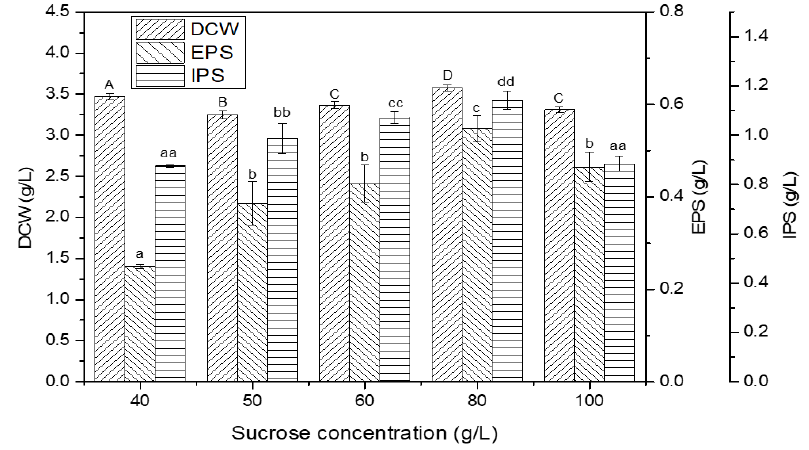
Figure 2. Effect of different sucrose concentrations on mycelial growth (DCW: dry cell weight) and polysaccharides (EPS: exopolysaccharide; IPS: intracellular polysaccharide) production. The letters above bars are the same indication as shown in Figure 1.